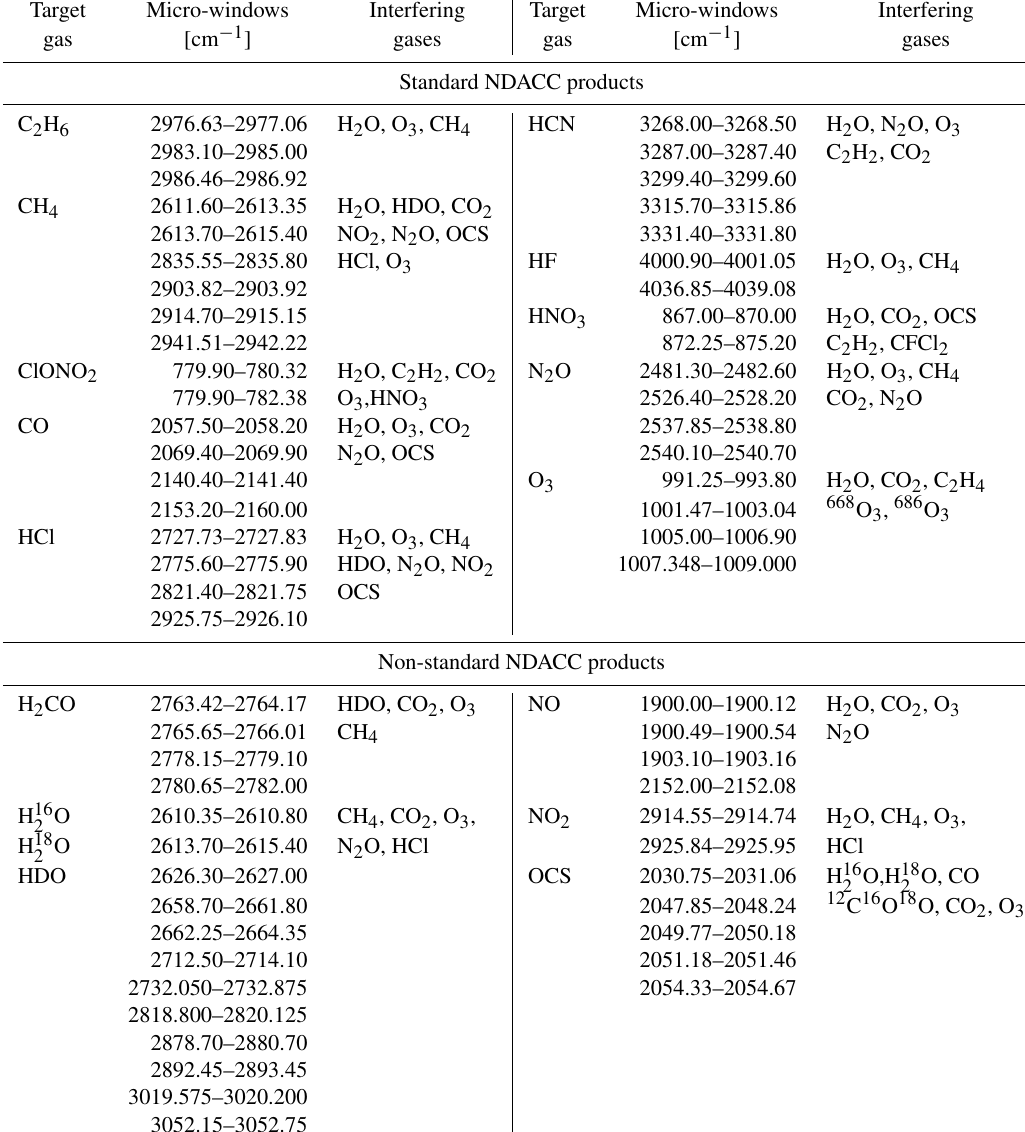
Table 2. Summary of the spectral regions and interfering gases considered for standard and non-standard NDACC products at IZO. For details about specific retrieval strategies for the non-standard products refer to Vigouroux et al. (2018) for H 2 CO, to Schneider et al. (2016) and Barthlott et al. (2017) for water vapour isotopologues, to Hase (2000) and Rinsland et al. (2003) for NO and NO 2 , and to Lejeune et al. (2016) for